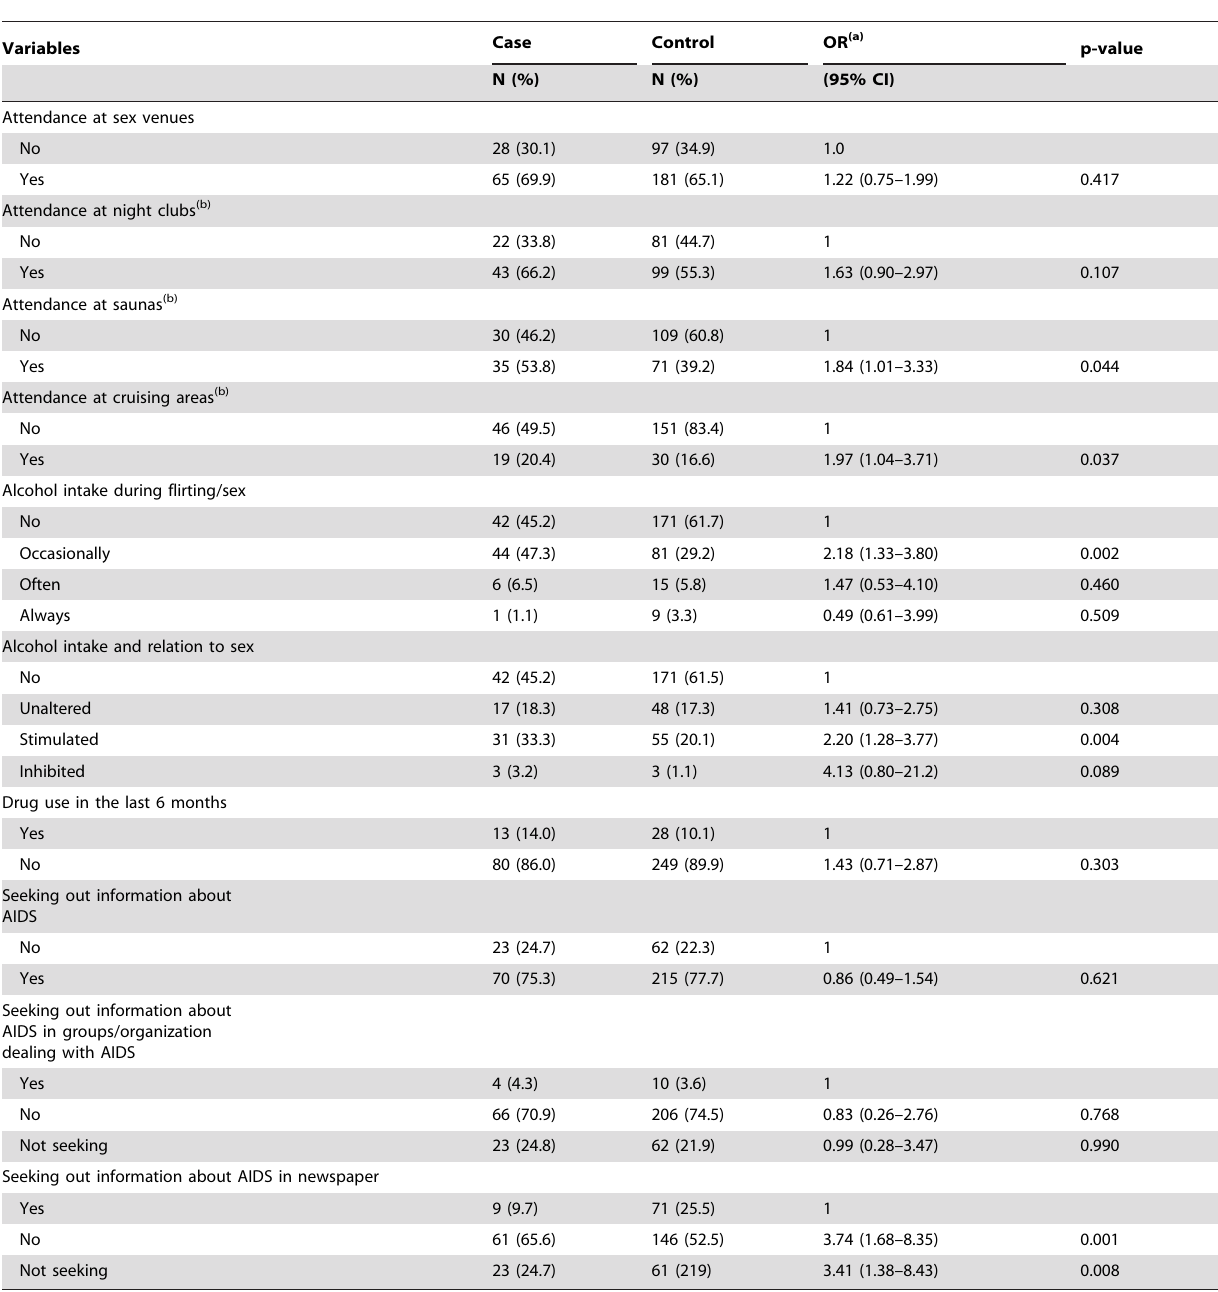
Table 3. Univariate analysis of the contextual characteristics, comparing HIV-positive and HIV-negative controls, Project Horizonte,